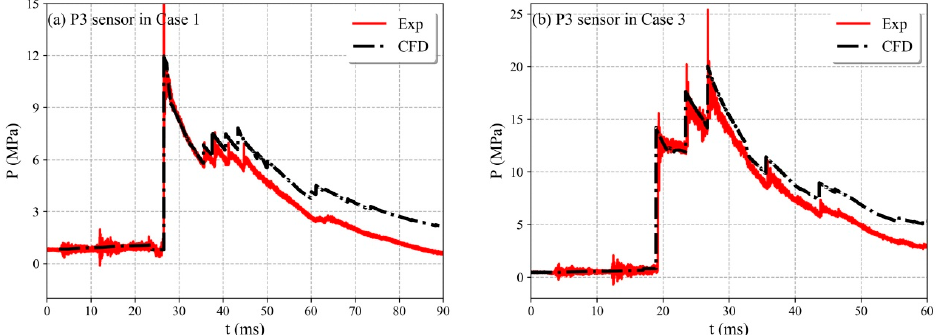
Figure 9. Pressure histories of the P3 sensor. ( a ) Case 1; ( b ) Case 3.